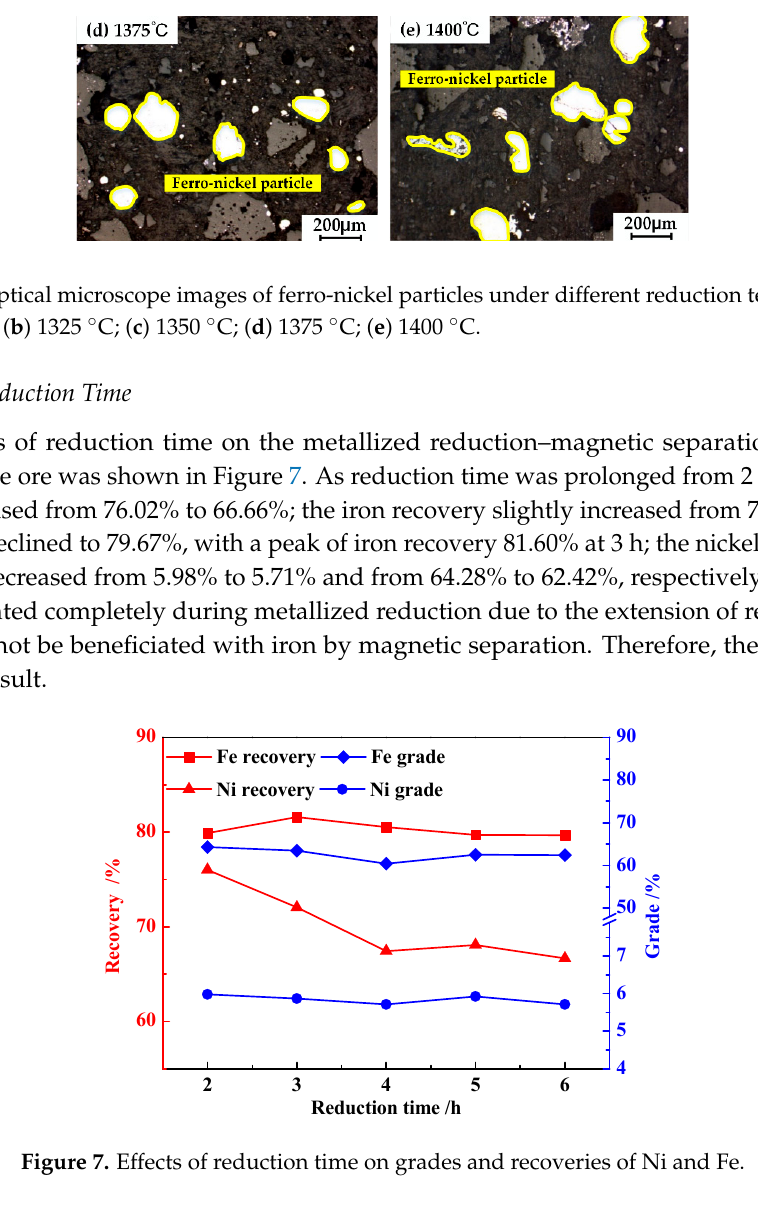
Figure 7. Effects of reduction time on grades and recoveries of Ni and Fe.